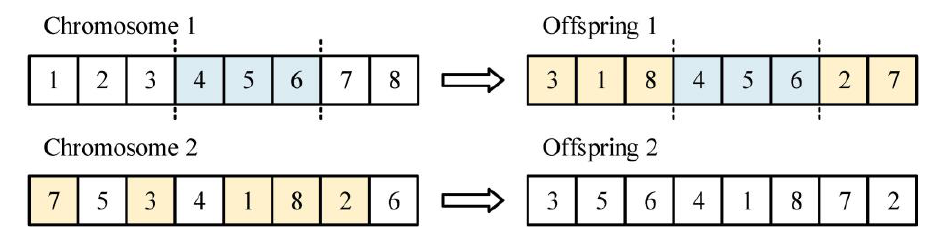
Figure 5. Example of the mutation operation. Figure 4. Example of the mutation operation.